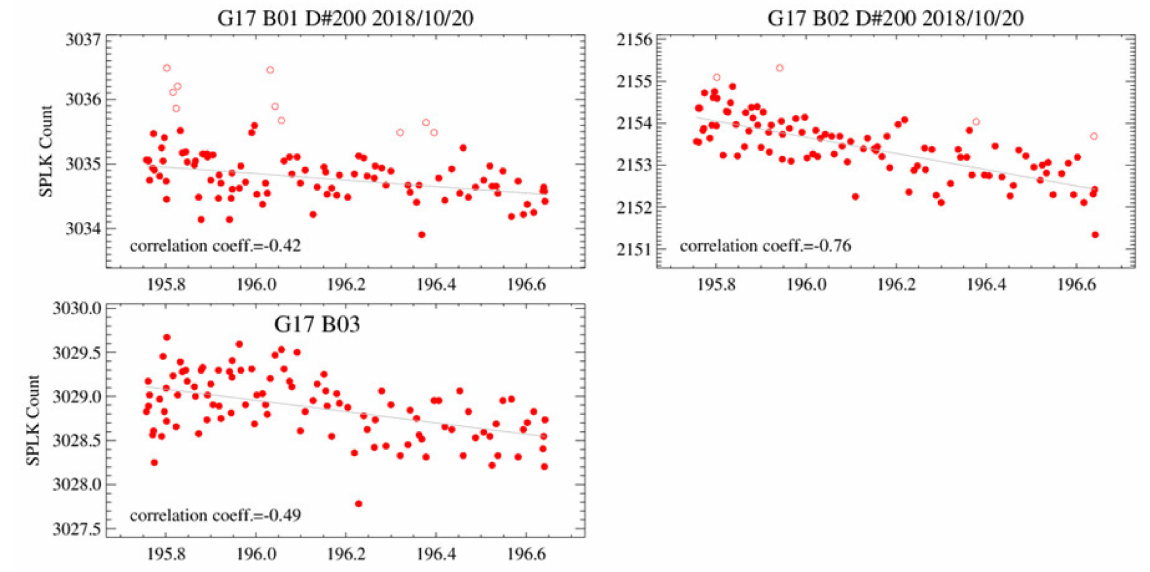
Figure 13. Linear relationship between the SPLK count and the VNIR FPM temperature for G17 on 20 October 2018 using detector #200 as an example. The open circles detected at B01 and B02 are outliers, and the solid circles are used for the final linear regression